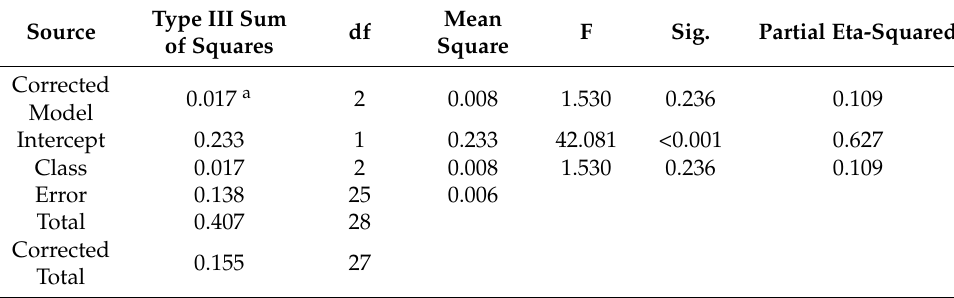
Table 1. Tests of between-subjects effects. Type III Source